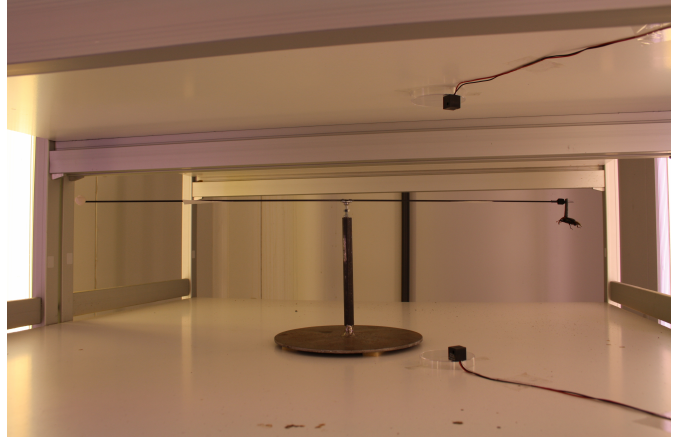
Figure 9. Rack detail with an R. ferrugineus individual tethered to the